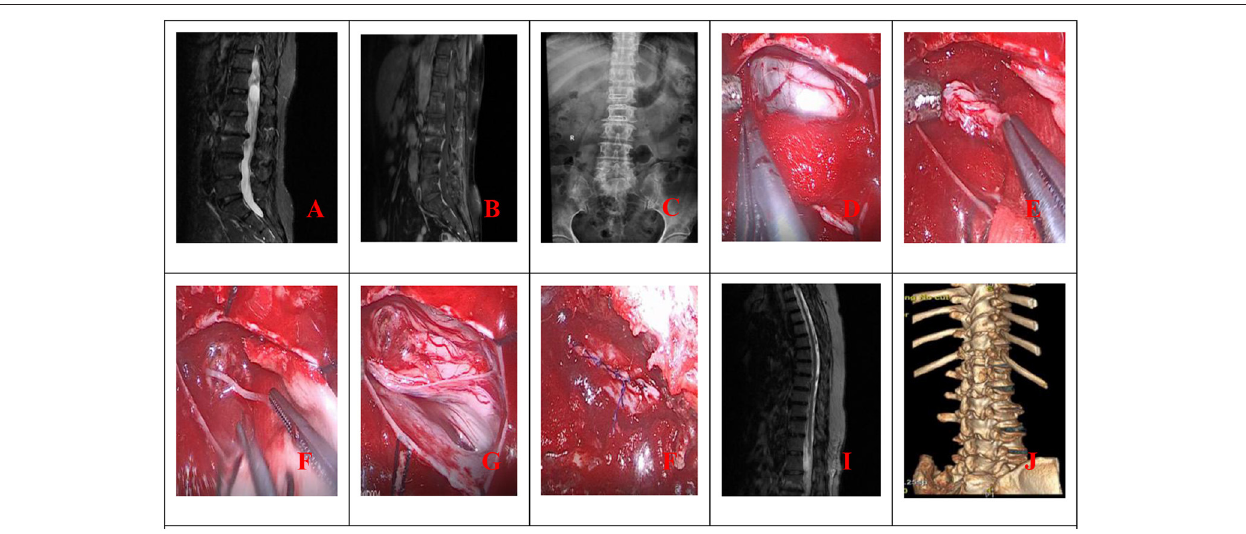
FIGURE 1 | (A) Preoperative MRI; (B) Preoperative MRI enhancement; (C) Position the cone preoperatively; (D) Open the dura mater under endoscope; (E) Separate and pull out the tumor under endoscope; (F) Cut off the tumor-bearing nerve after endoscopic electrocoagulation and remove all the tumor; (G) Endoscope demonstrated good nerve root protection after tumor resection; (H) Continuous suture of spinal dura under endoscope; (I) Postoperative MRI revealed total tumor resection (J) . Postoperative 3D CT reconstruction.